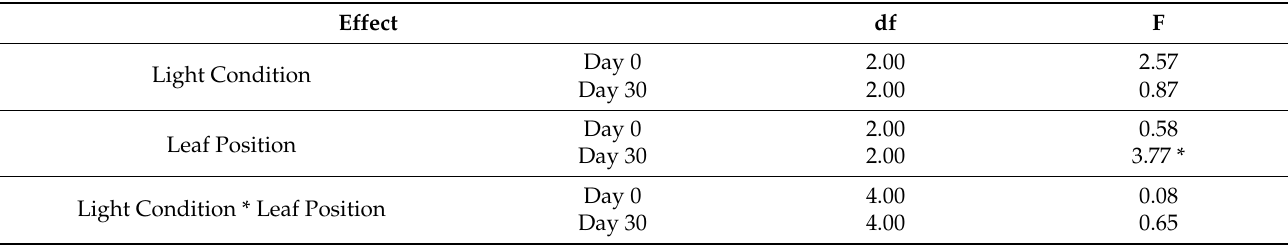
Data are presented as means ± standard error (n = 5). Different lowercase letters represent significant differences in chlorophyll contents under different light conditions, and uppercase letters show significant differences between 0 and 30 days in various leaf positions based on Tukey HSD test at P < 0.05 level. Table 5. Analysis of variance results of the effect of light conditions and leaf positions on the concentration of chlorophyll of Anthurium × ‘Red’ before and after placement in interior rooms.